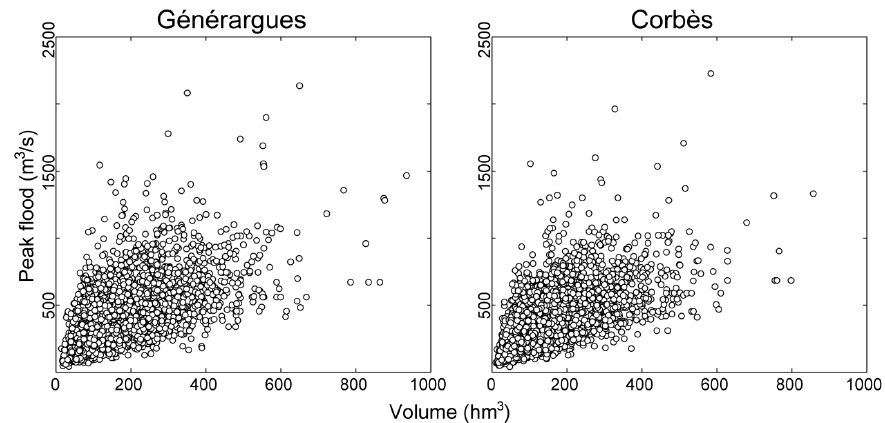
Figure 12. Peak flow and hydrograph volumes of the simulated hydrograph for the Générargues and the Corbès basins.